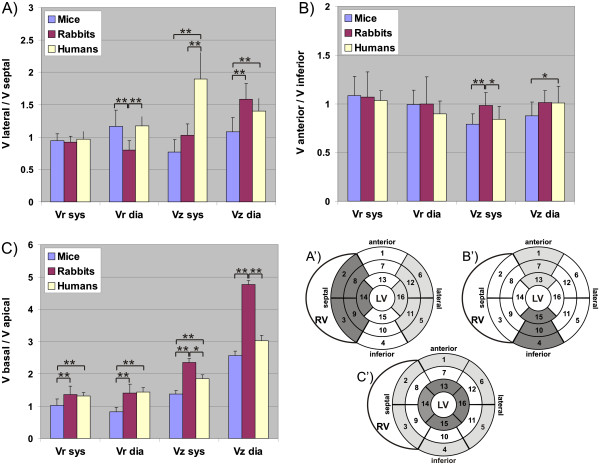
Velocity ratios lateral/septal (A), anterior/inferior (B), and basal/apical in murine, rabbit and human hearts for radial and long-axis velocities during systole and diastole. Significant differences between species are indicated by *(p<0.05) and **(p<0.001). A’-C’: pictograms of AHA 16-segment models that illustrate the regions used for ratio calculation in A-C, regions are highlighted in dark and bright grey.